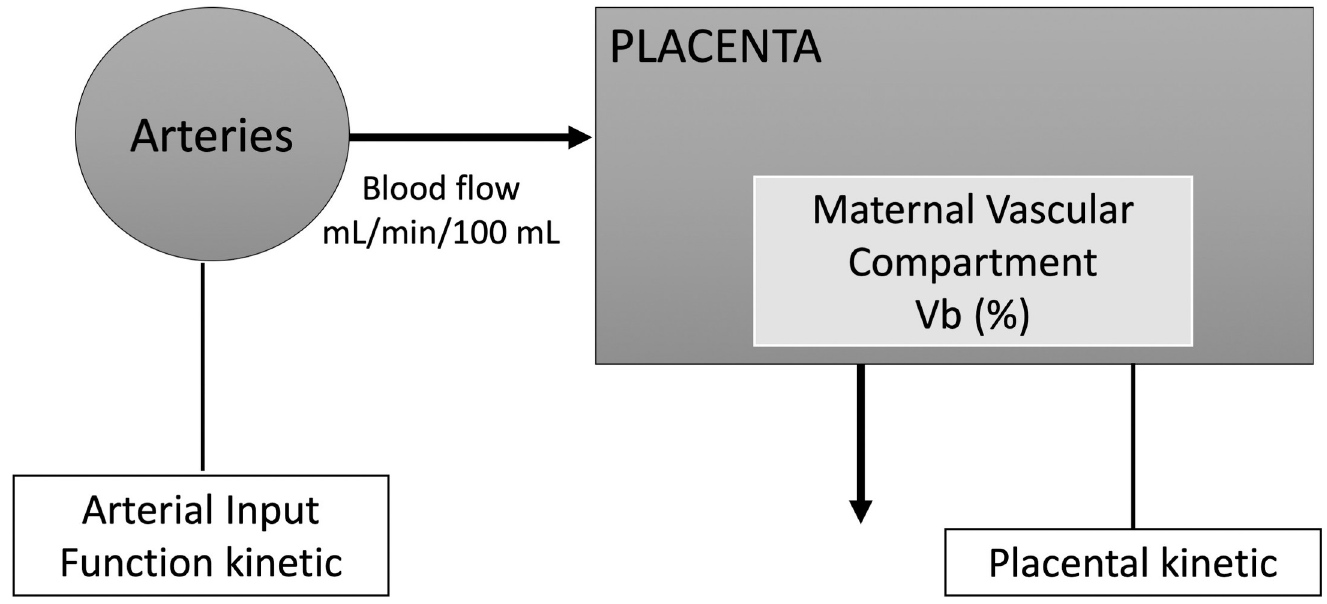
Fig 1. One-compartment